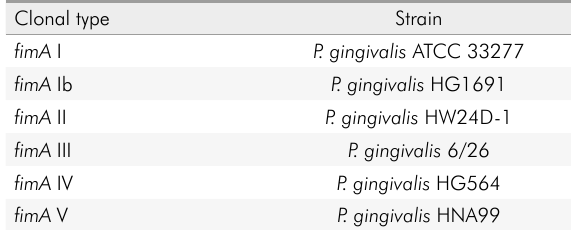
Table 1. Strains used as positive